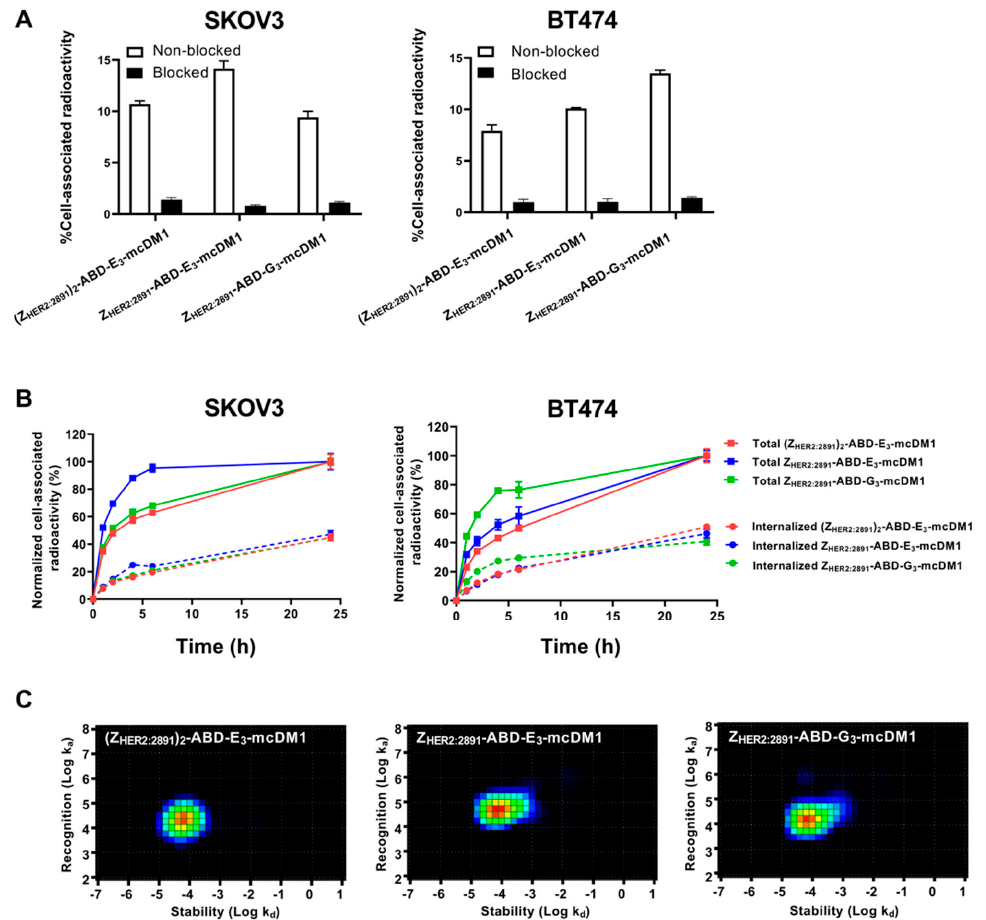
Figure 3. Cell binding and cellular processing of 99m Tc-labeled AffiDCs. ( A ) SKOV3 and BT474 cells were incubated with radiolabeled AffiDC with or without pre-saturation with a 500-fold molar excess of the same AffiDC lacking radiolabel, blocked or non-blocked, respectively. The Y-axis corresponds to the measured total radioactivity of the cells as a percentage of the total radioactivity added to each well. ( B ) Cellular processing of 2 nM conjugates by SKOV3 and BT474 cells during continuous incubation over 24 h. Data were normalized to the recorded value at 24 h, which was set to 100%, and are presented as mean with error bars corresponding to 1 SD. ( C ) Interaction maps for the interaction between 99m Tc labeled AffiDCs and SKOV3 cells. The maps were derived by InteractionMap software from real-time biosensor measurements in a LigandTracer instrument. The x-axis corresponds to the dissociation rates and the y-axis corresponds to the association rates of the interactions in each graph.